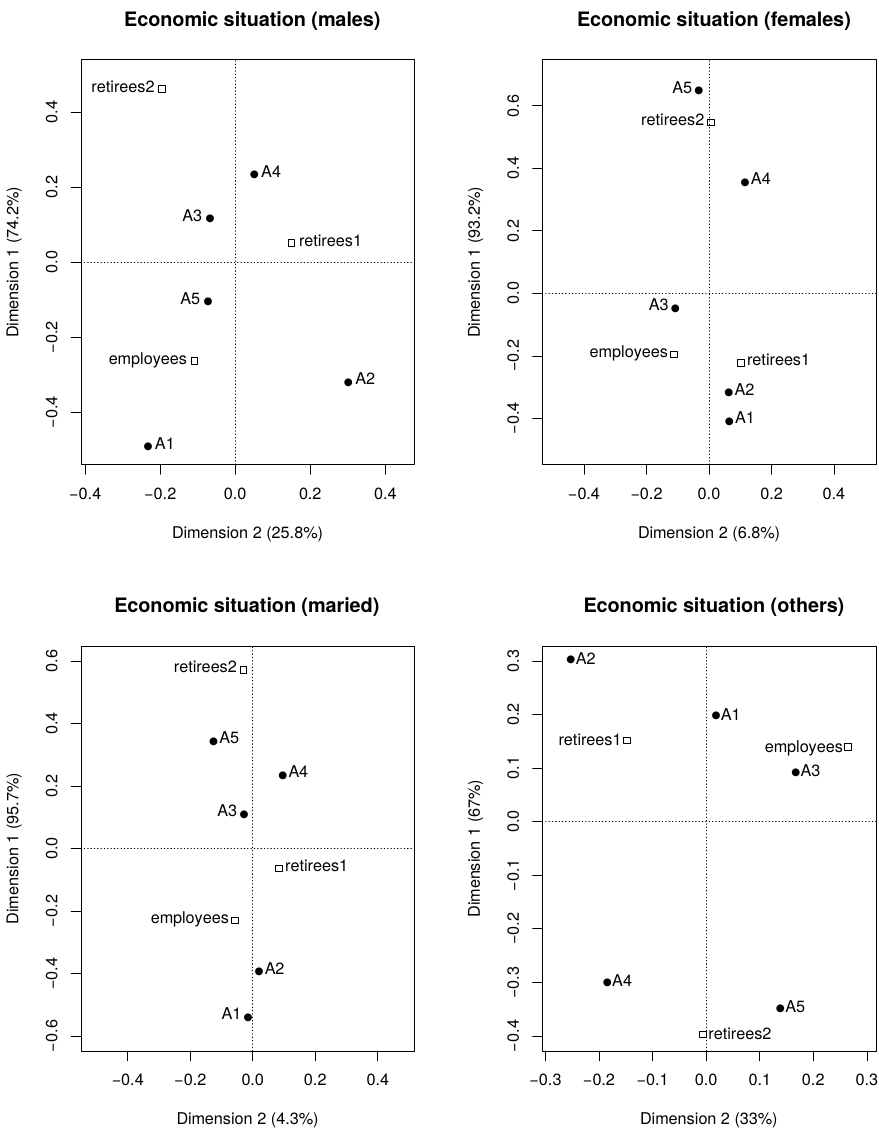
Figure 3. Classification maps (questions No. 19E and